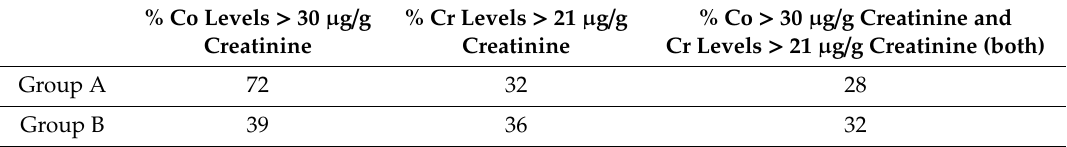
Table 3. Urine Co and Cr mean values adjusted to